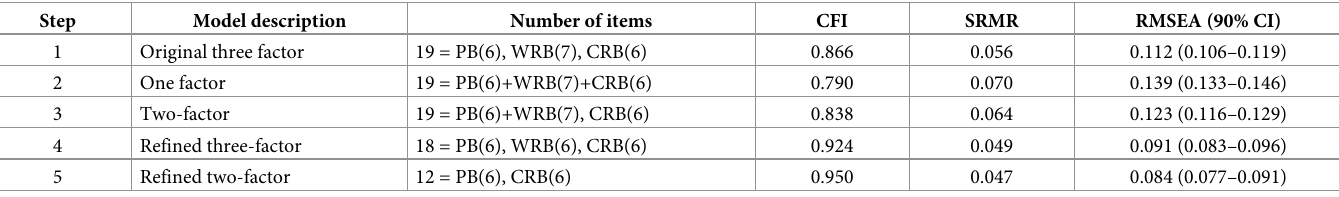
Table 2. Goodness-of-fit indices of the factor models of the Korean version of the Copenhagen Burnout Inventory among Korean homecare workers working with elderly community-dwelling individuals (N = 464).